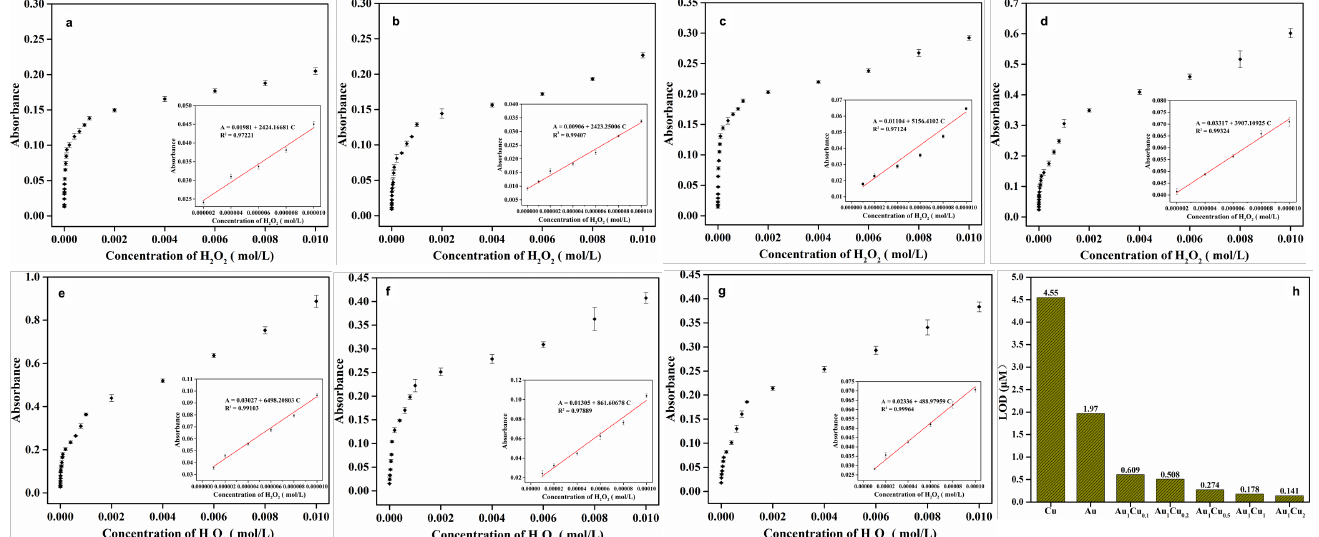
Figure 5. ( a – g ) Dose-response curves for H 2 O 2 detection using ( a ) Au 1 Cu 0.1 , ( b ) Au 1 Cu 0.2 , ( c ) Au 1 Cu 0.5 , ( d ) Au 1 Cu 1 , ( e ) Au 1 Cu 2 , ( f ) Cu, and ( g ) Au as peroxidase mimetics. Inset of a – e : Linear range of absorbance intensity versus H 2 O 2 concen- tration. ( h ) Limit of detection (LOD) for H 2 O 2 of Au 1 Cu 0.1 , Au 1 Cu 0.2 , Au 1 Cu 0.5 , Au 1 Cu 1 , Au 1 Cu 2 nanoparticles, Cu nanopar- ticles, and Au nanoparticles.